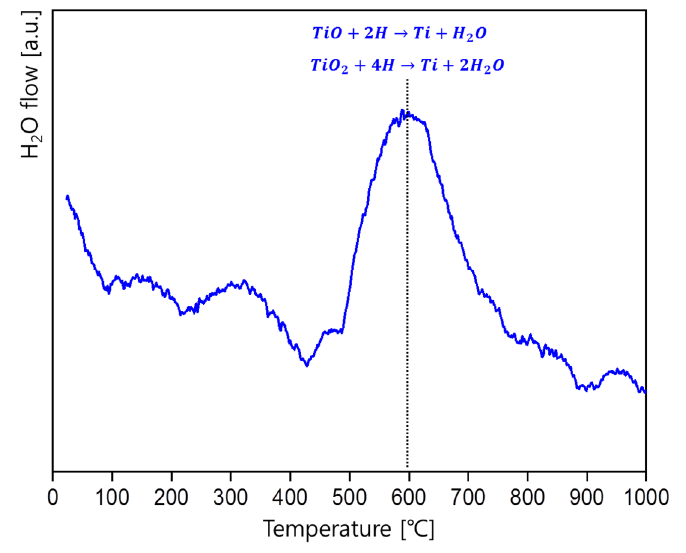
Figure 7. GD-MS result of TiH 2 during dehydrogenation process. The amount of H 2 O flow was measured with respect to the temperature. measured with respect to the